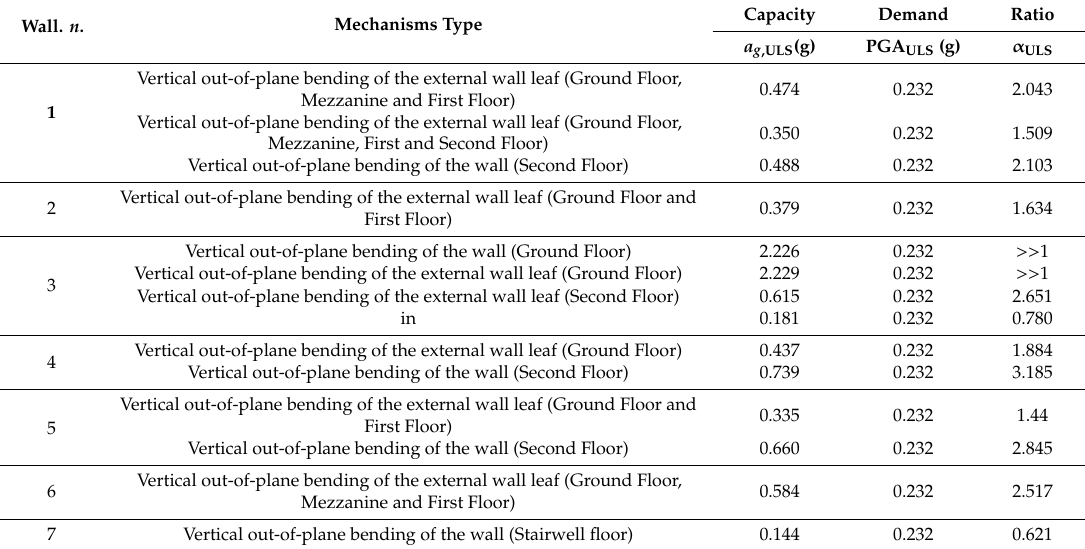
Table 2. Results obtained from the analysis of the out-of- plane failure mechanisms. Wall. n